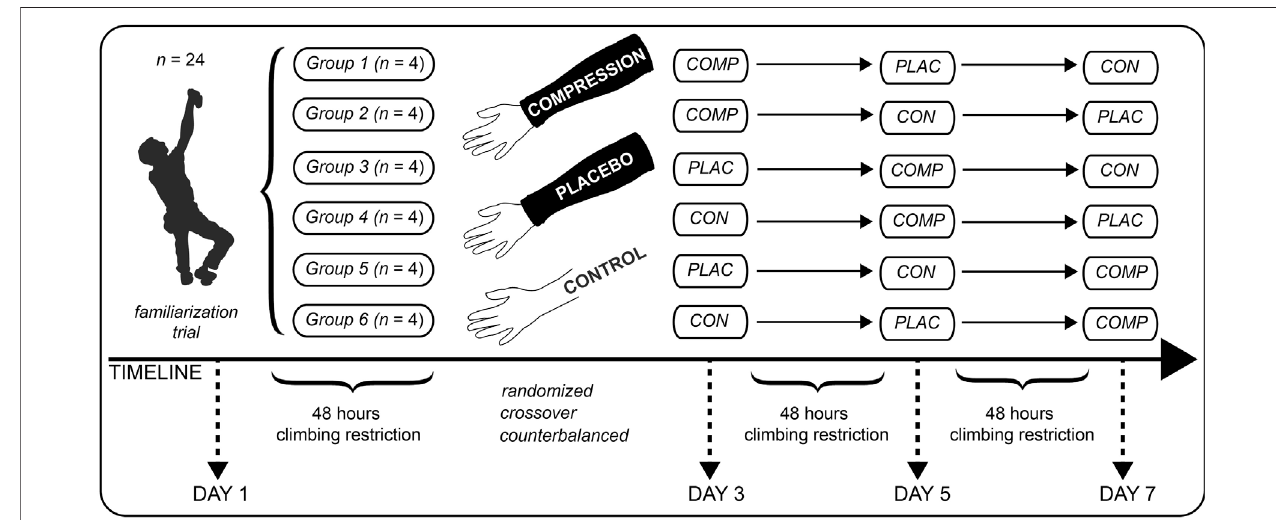
FIGURE 1 | Experimental